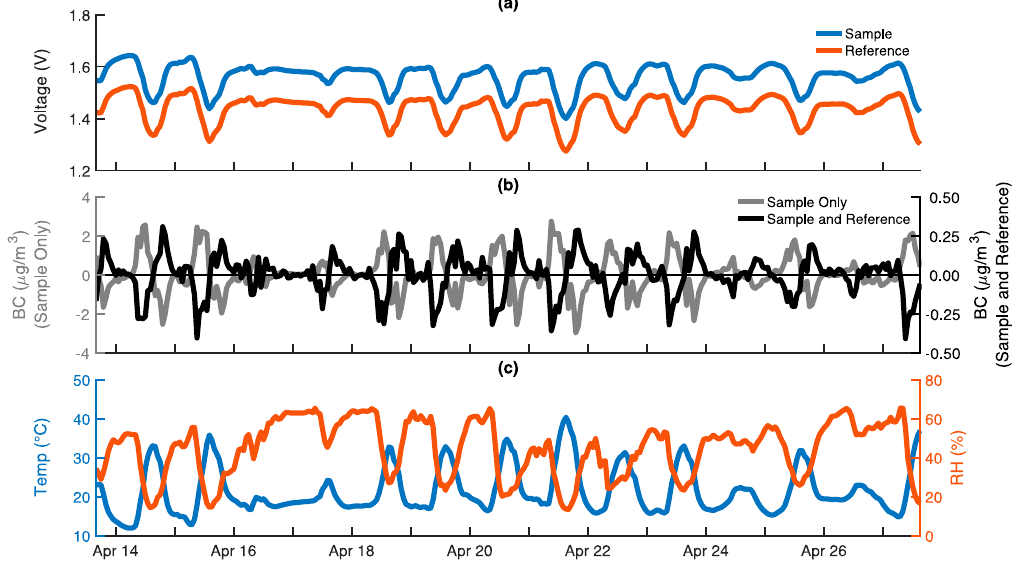
Figure 4. The response of an ABCD operating outdoors with a HEPA filter on its air inlet for two weeks: ( a ) Sample (blue) and reference (red) voltage outputs from optical cell; ( b ) Black carbon (BC) concentrations calculated using only sample voltage (gray), and using both the sample and reference voltages (black); ( c ) Optical cell temperature (blue) and relative humidity (RH) (red). All data is provided on a 60-m time base.